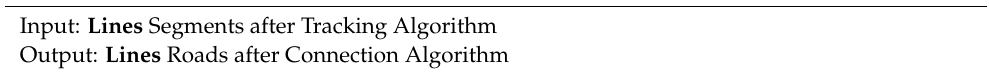
The pseudocode of the road connection algorithm in Algorithm 2: Algorithm 2: Road